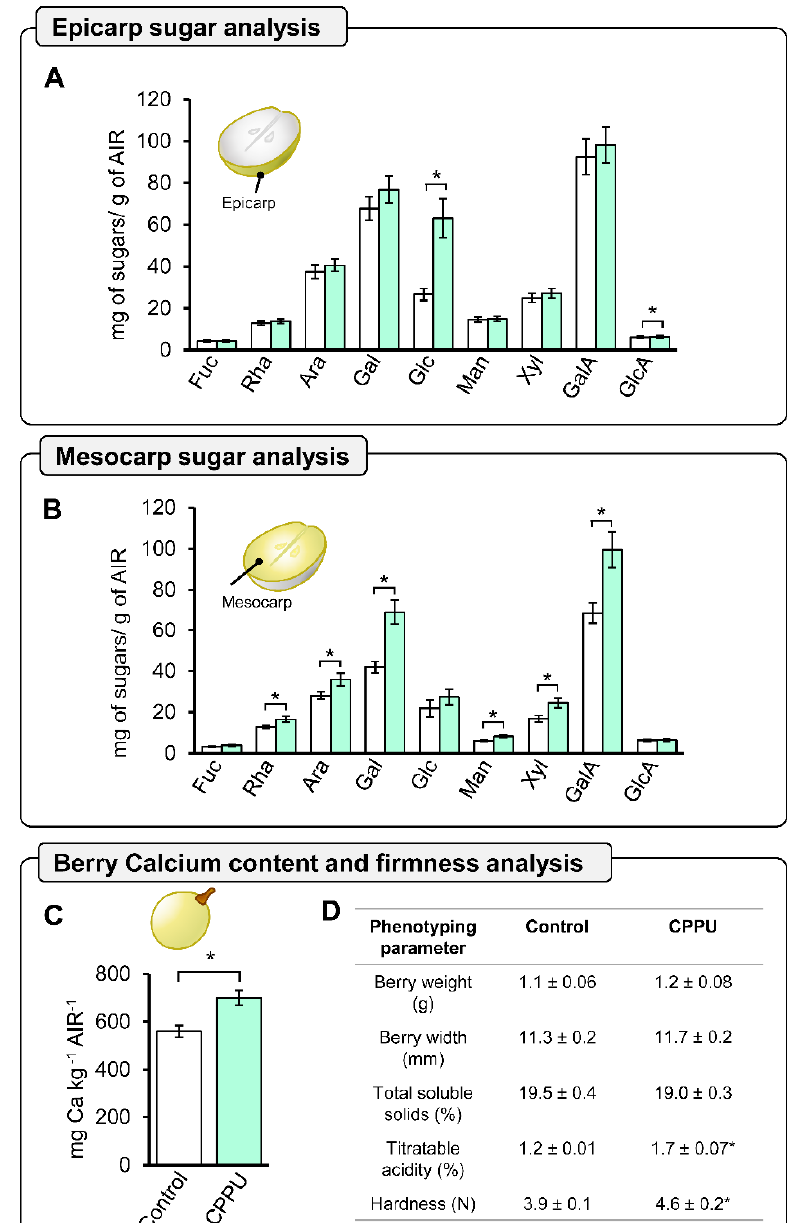
loglucan. Images of ovary were digitally extracted and placed on the same background for pheno- type comparison. Scale bars = 200 μ m.